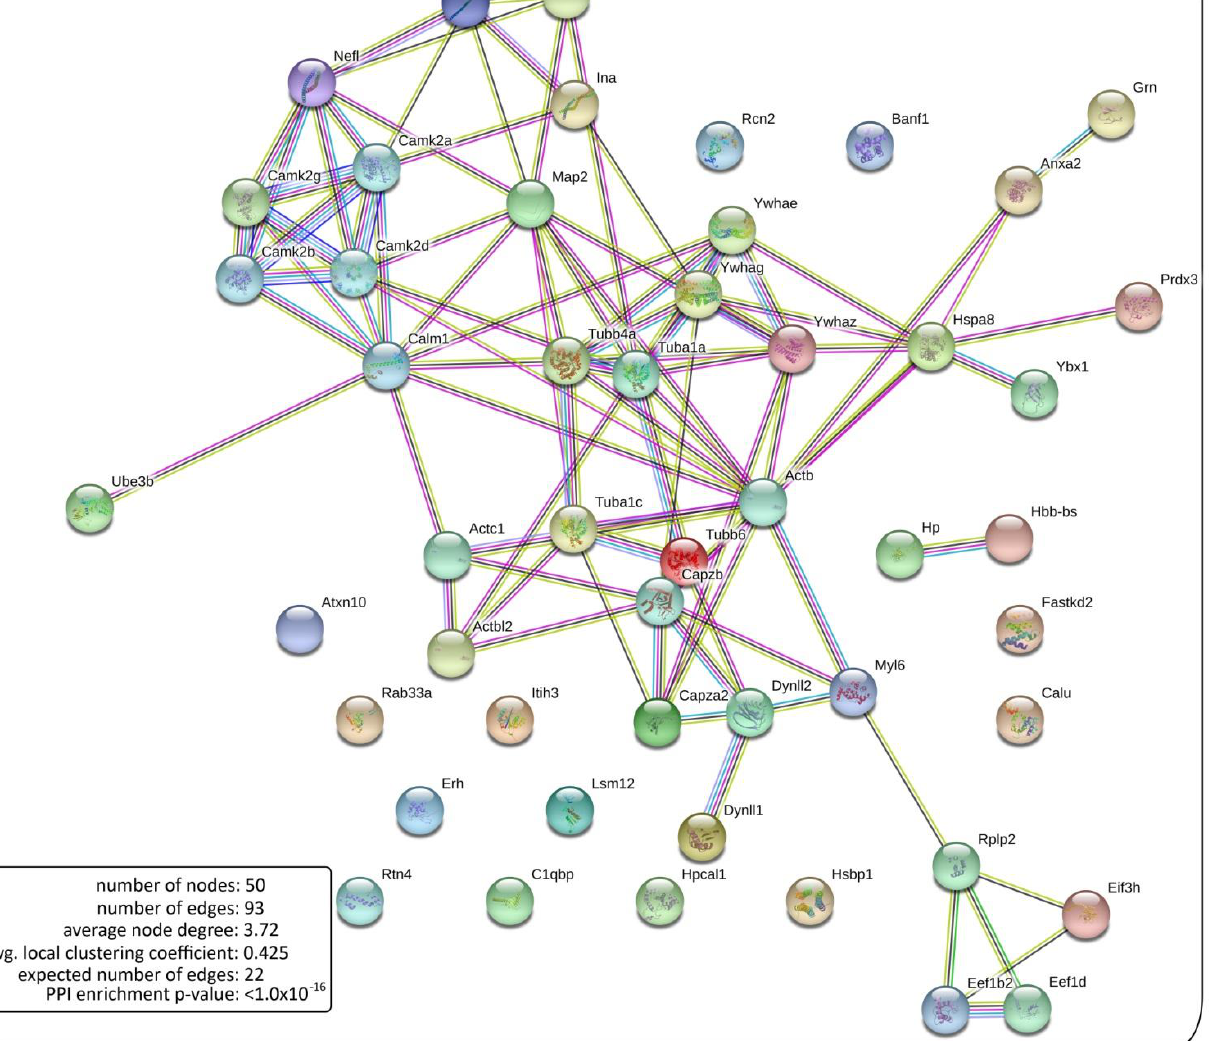
Figure 4. NCAM2 protein interaction network. Bitmap representation of the NCAM2 interaction network. The network edges mean the evidence of interactions between the proteins of Table 1, proteins detected with two or more peptides in the mass spectrometry assay. Our bitmap shows a significant increased number of edges, 93 edges with our pull versus 22 expected in random condition.